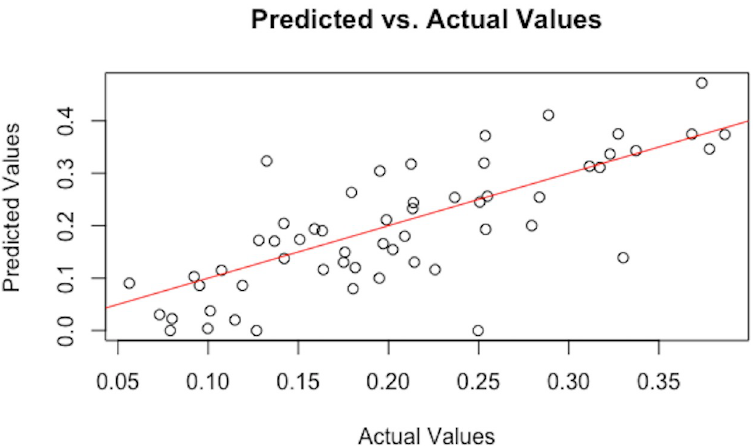
Fig 1. Actual FA values vs predicted values. This is a scatter plot of actual FA values vs predicted FA values for one significant voxel v = (150, 80, 75) across 57 individuals.